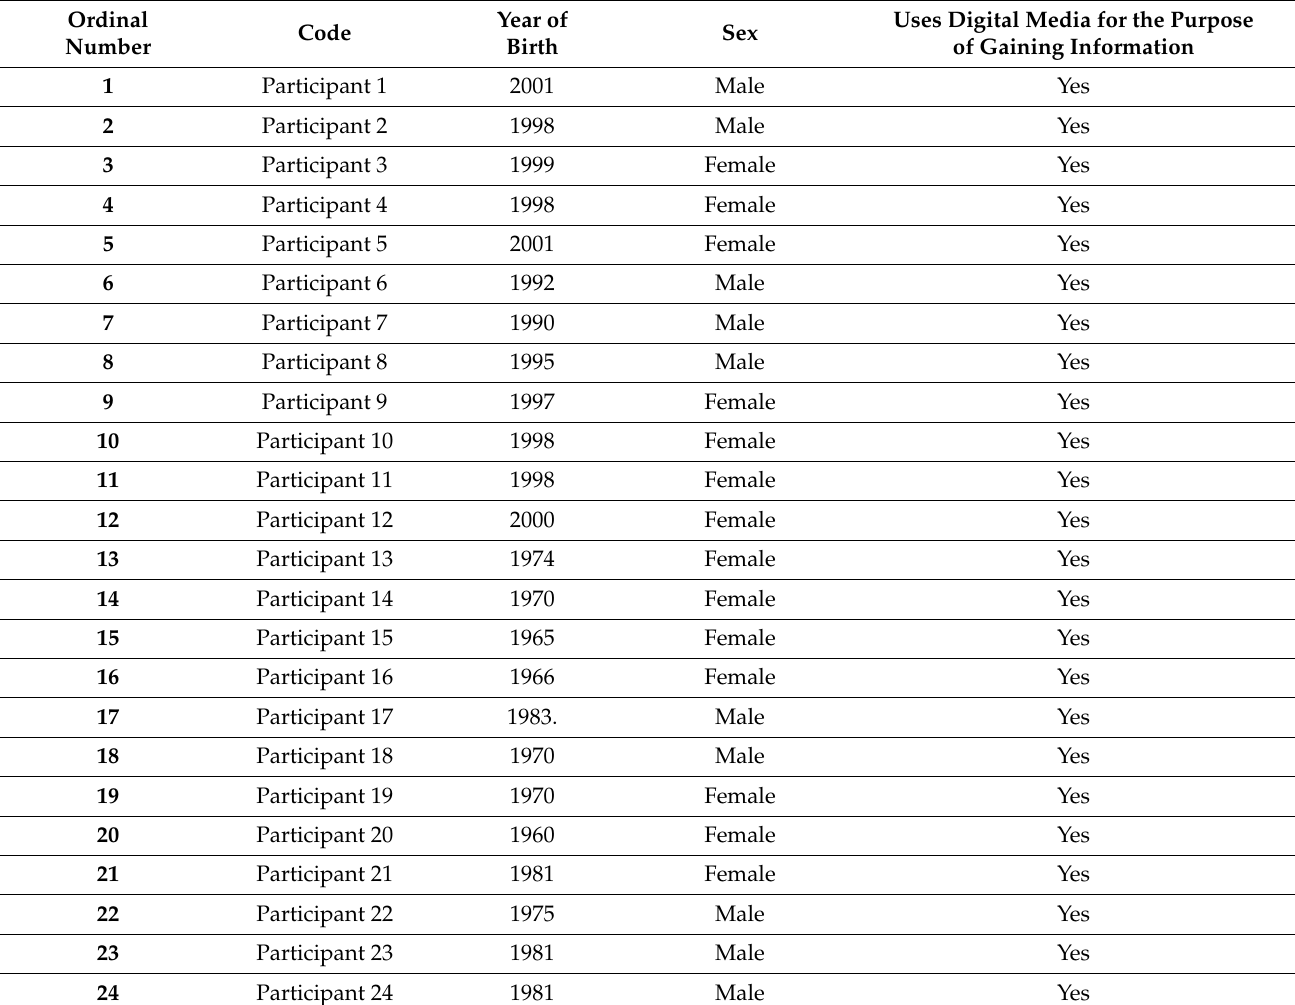
Table A1. List of participants in focus